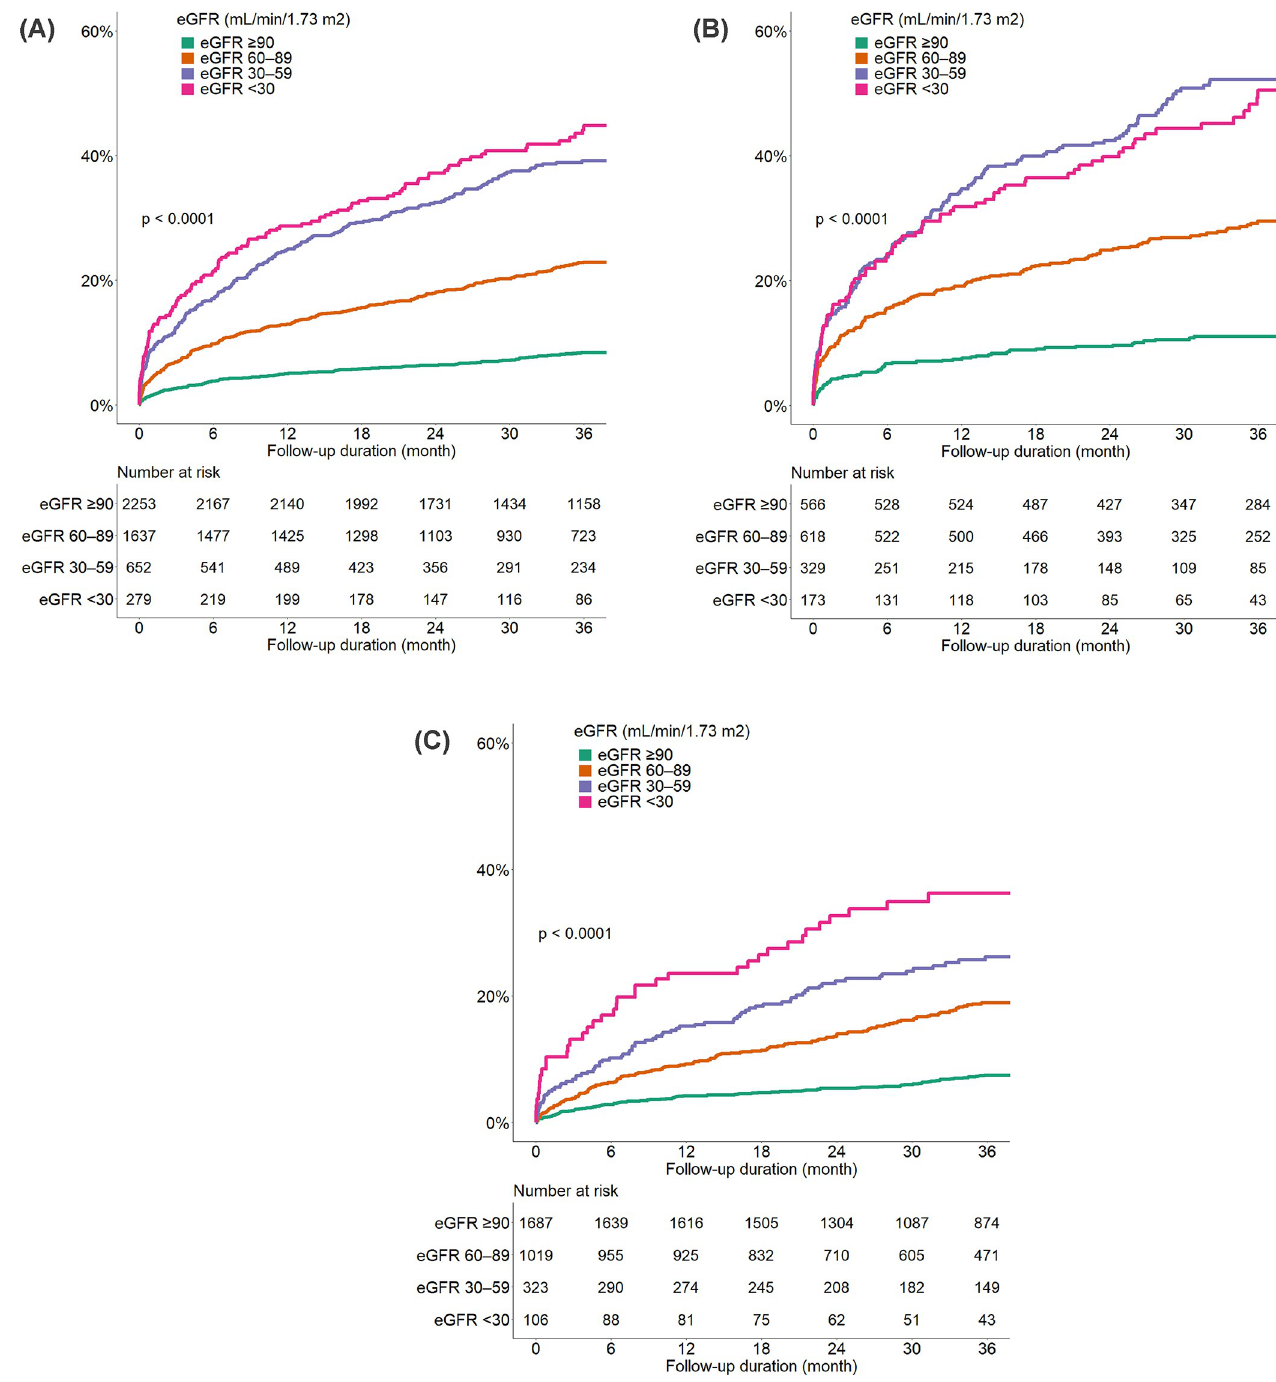
Fig 2. Cumulative all-cause mortality according to the estimated glomerular filtration rate in (A) all patients, (B) patients with hypertensive emergency, and (C) patients with hypertensive urgency.